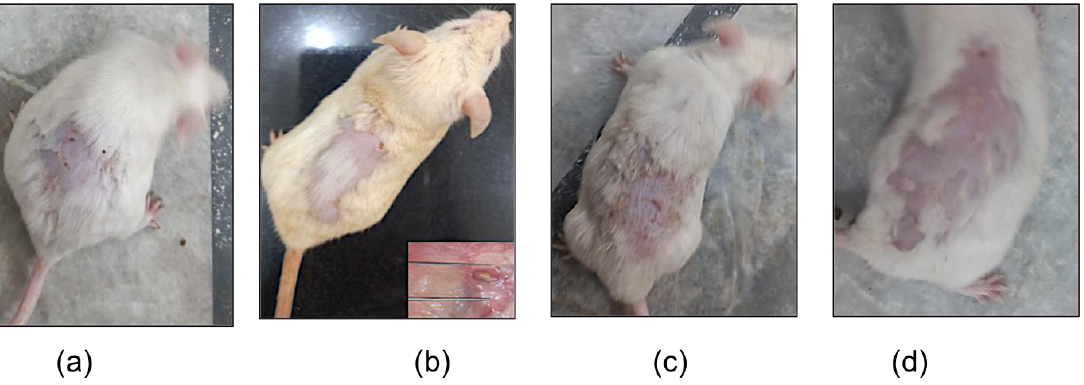
Figure 10. Testosterone-induced acne model in ( a ) normal groups, ( b ) negative group, ( c ) positive group, and ( d ) treatment group at the end of the study.